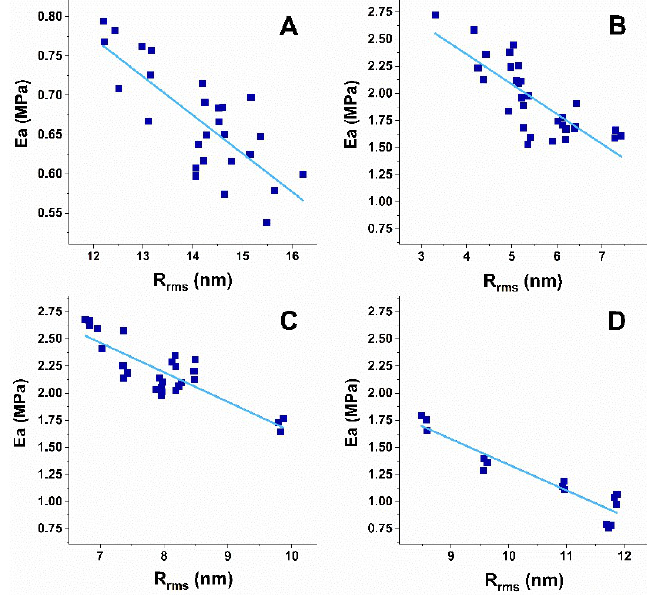
Figure 5. Scatter plots of E a against R rms for platelets derived from the healthy individuals ( A ) and the PD ( B ), ALS ( C ) and AD ( D ) patients.